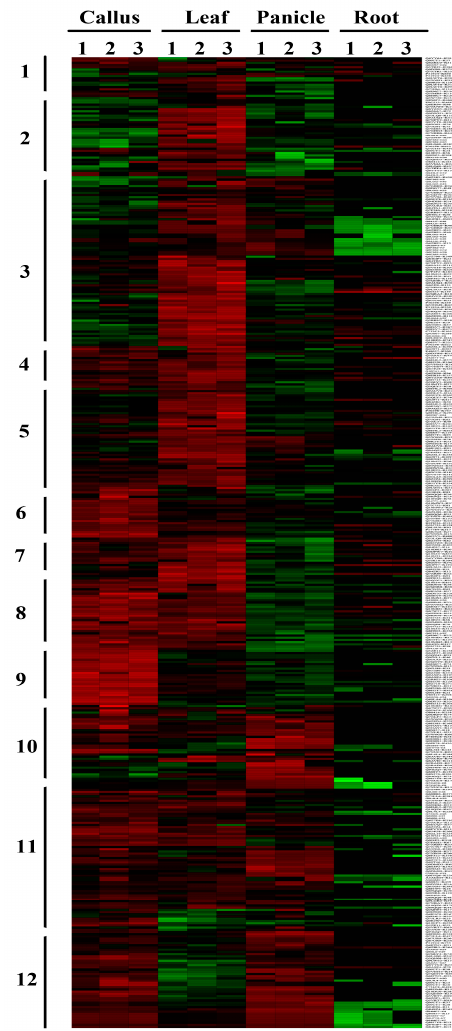
Figure 6. Hierarchical clustering analysis of the DA proteins in the callus, leaf, panicle, and root; Color bar at the bottom represents the log 2 acetylation site quantitation values. Green, black, and red indicate the low, medium, and high acetylation intensity, respectively .